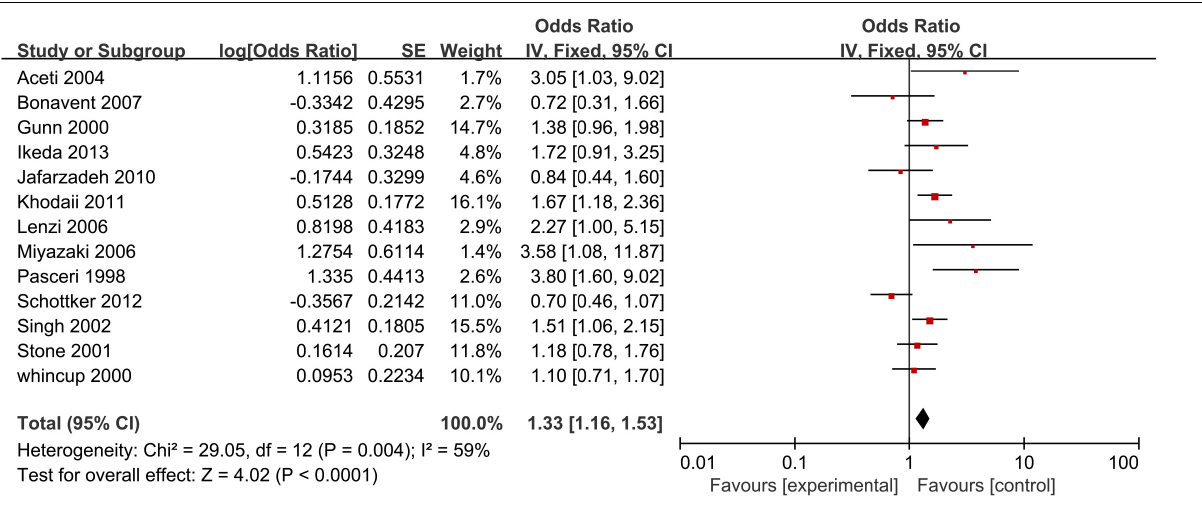
FIGURE 5 | Relationship anti-CagA test and